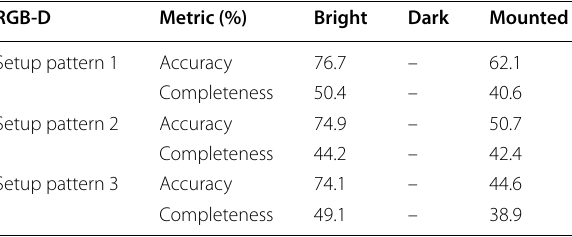
Table 13 Performance comparison of RTAB-Map (RGB-D) under different illumination conditions and setup patterns RGB-D